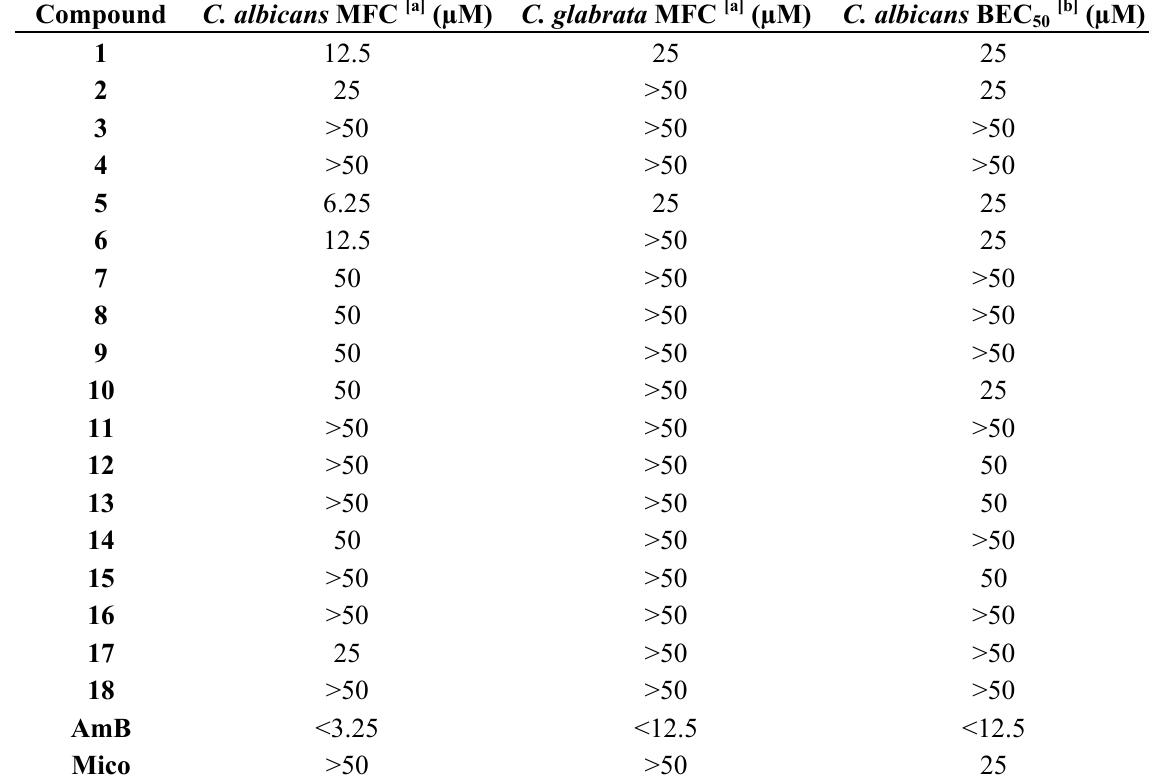
Table 2. Antifungal activity of 2,6-disubstituted quinolines against C. albicans , C. glabrata and C. albicans